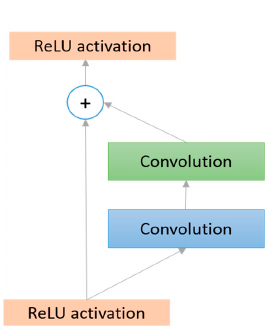
Figure 16. Basic diagram of the Residual block.